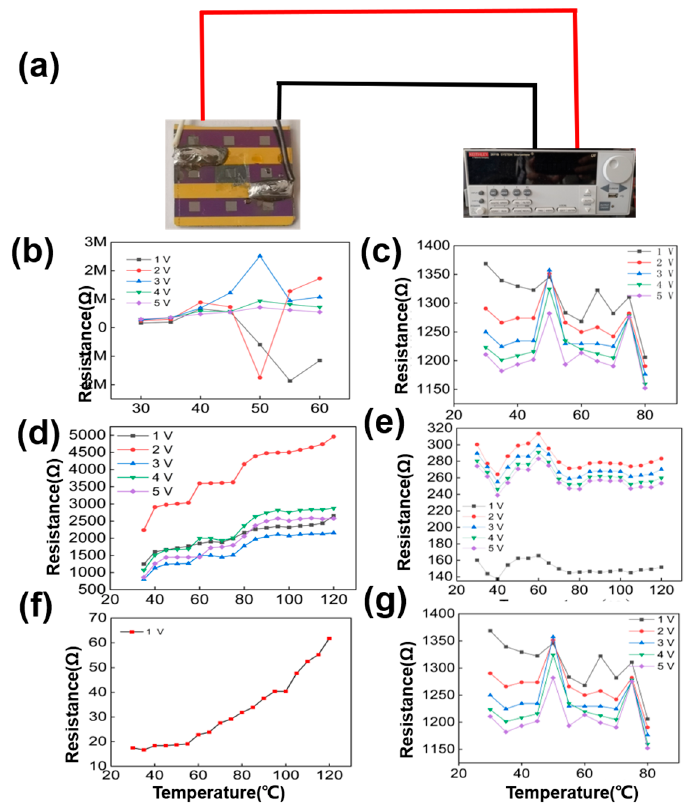
Figure 4. ( a ) Test data of resistance of different devices with temperature. ( b , d , f ) is the test data of monolayer/few − layer/multilayer graphene on cavity substance and ( c , e , g ) are the test data of the monolayer/few − layer/multilayer graphene on non − cavity substance. The breakdown voltage of multilayer graphene, in Figure 4 ( f ), is less than 2 V due to its resistance limitation. Therefore, only 1 V bias voltage is available for this sample.